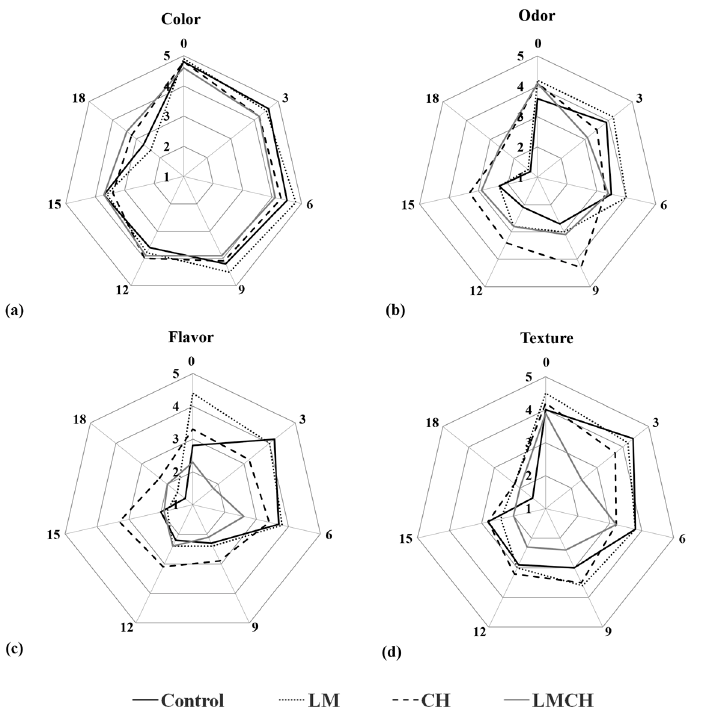
Figure 3. Sensory quality parameters—( a ) color, ( b ) odor, ( c ) flavor, and ( d ) texture—of fresh-cut cantaloupe with and without an edible coating (control) during 18 days of storage at 4 °C. pH, TA, TSS, and AA